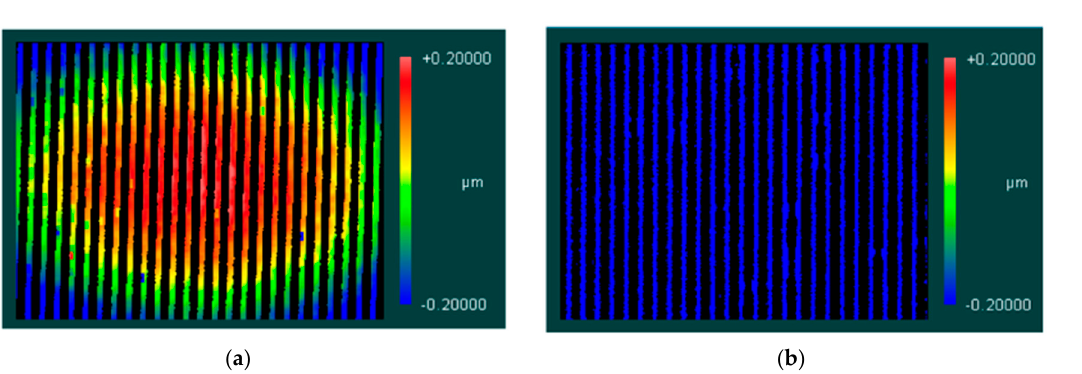
Figure 3. Surface contour profiles measured by 3D optical profilometer for ( a ) single-sided and ( b ) double-sided.